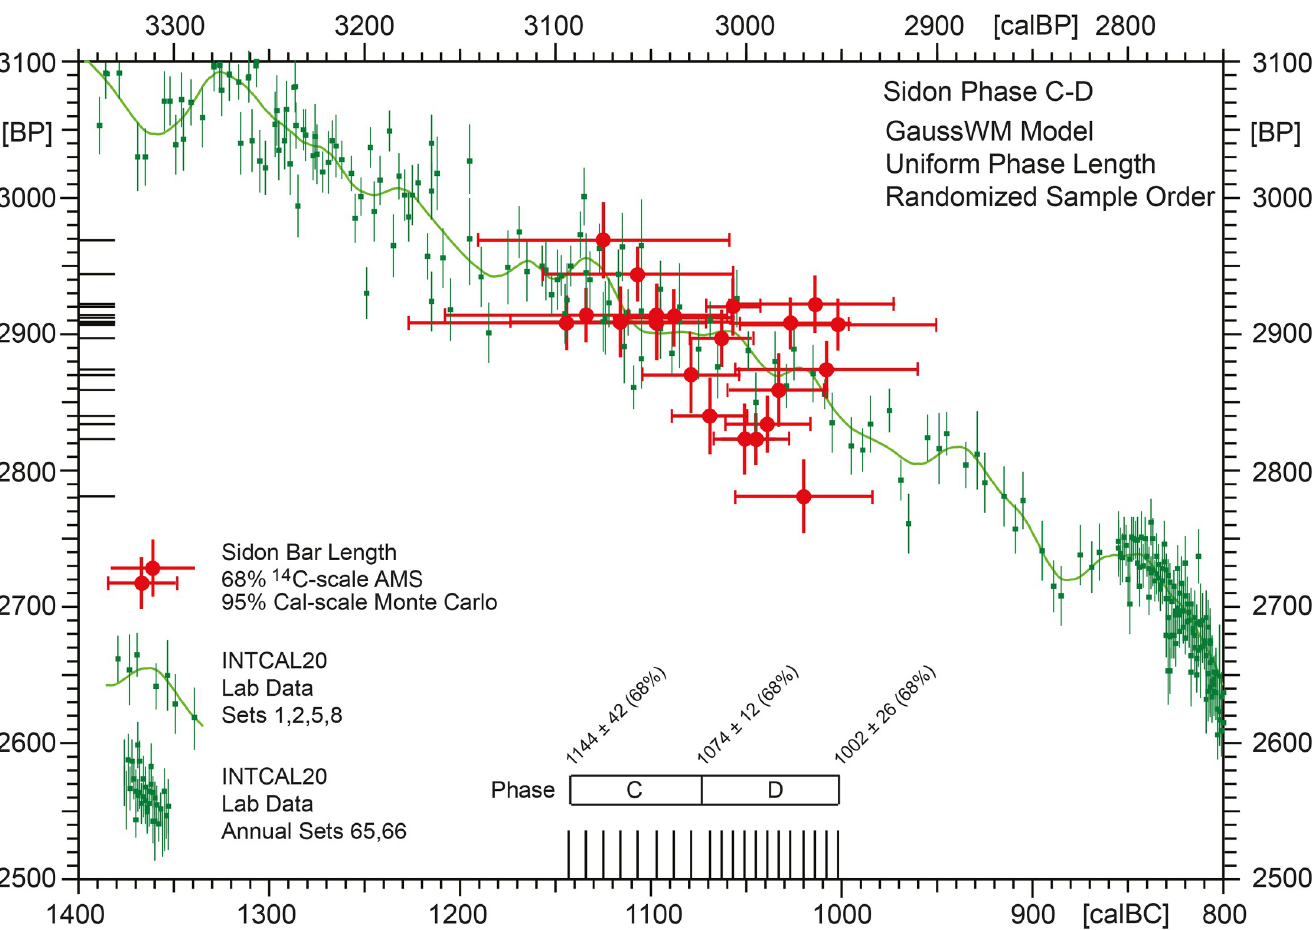
Fig 13. Archaeological uniform phase-length model for Sidon phases C-D, based on N = 20 stratigraphically filtered 14 C-dates (i.e.with outliers removed from Table 1 according to the outlier analysis, Fig 12. The 14 C-ages are arranged in the order of the stratigraphic layers from which the samples were taken, with layer- internal randomisation. The applied GaussWM-modelling is based on 1000 runs (run-time 24 hrs) with assumed Gaussian Monte Carlo modelling errors of ± 10 yrs for sample positions, ± 10 BP for calibration curve rebuilding, and application of a non-central chi-squared metric with non-centrality parameter λ = 10. Note that the specific sample-sequence shown as age-model in Fig 12 represents only one of several million alternative sequences, all of which contribute equally to the finally calculated model errors.